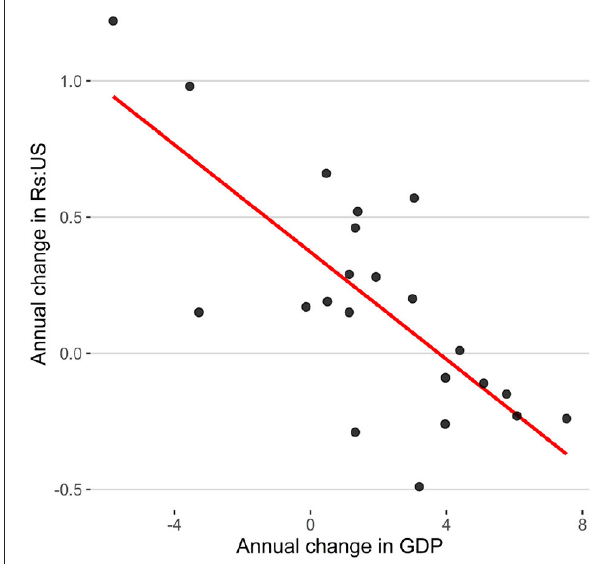
FIGURE 1 | Relationship between economic growth and the strength of the real. The strength of the real has closely followed changes in Brazil’s Gross Domestic Product. Large increases in GDP have correlated with the strengthening of the real against the dollar. Since 1999, each 1% increase in Brazil’s GDP corresponded with an approximate 7% decline in the value of the real against the U.S. dollar. Author’s calculations. Data drawn from ( FRED, 2020a